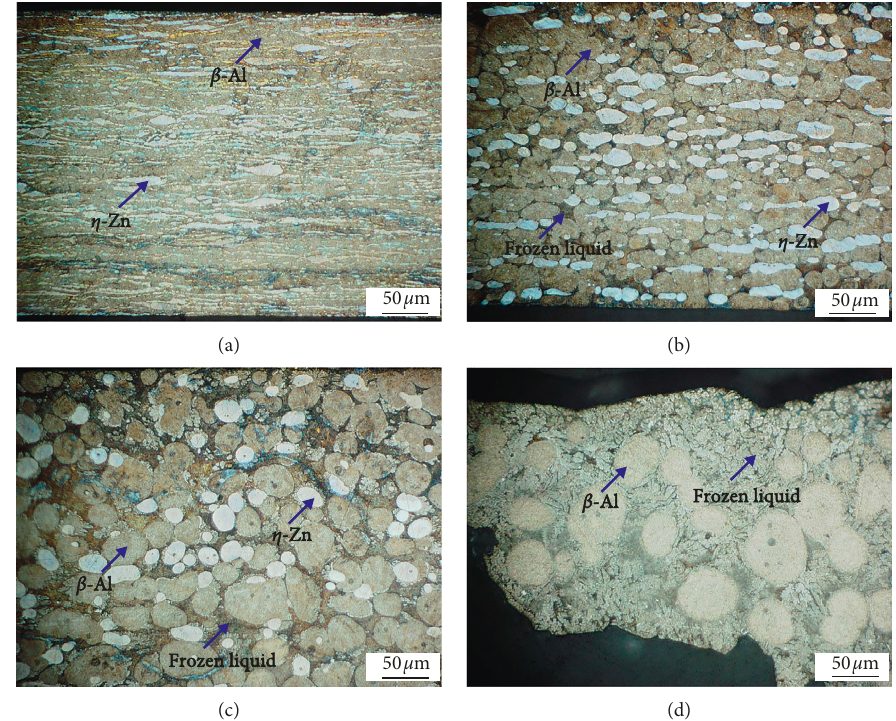
Figure 5: The microstructure of the filler metal heated to different temperatures without compression: (a) 382 ° C; (b) 386 ° C; (c) 392 ° C; (d) 410 ° C.